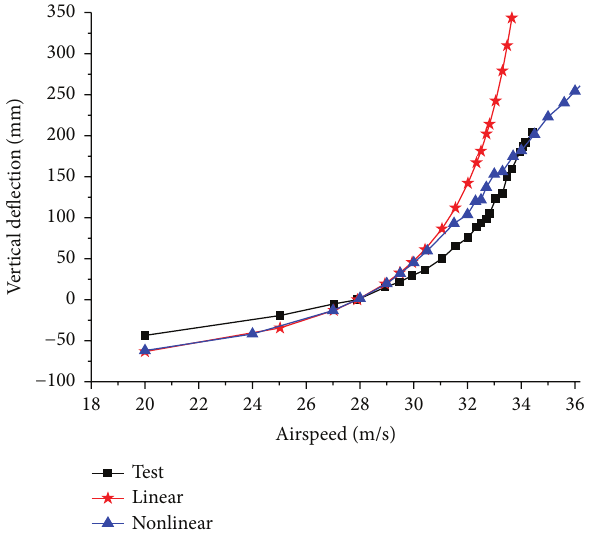
Figure 10: Vertical displacement at the wing tip versus